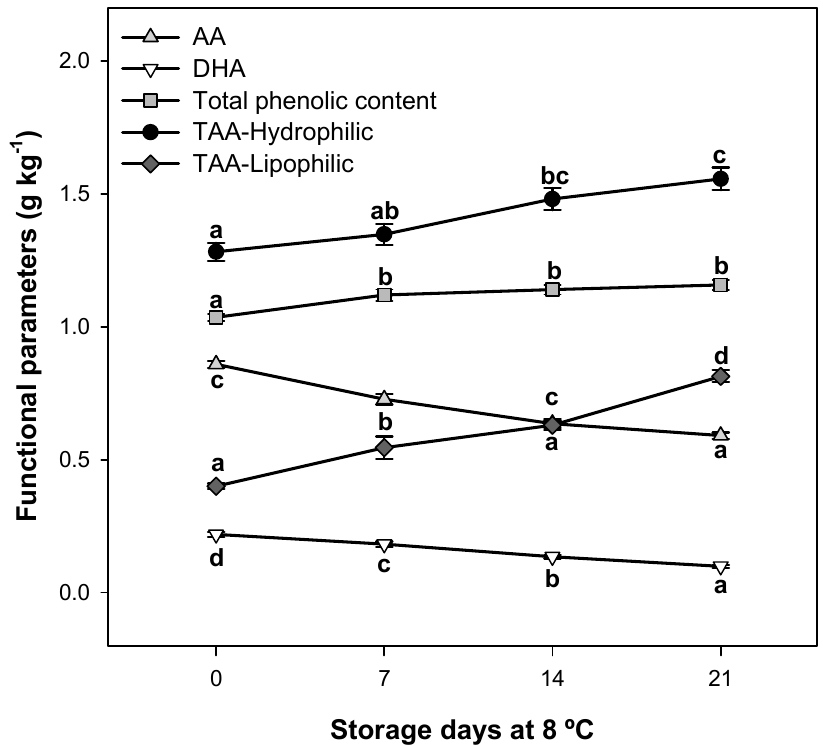
Figure 3. Evolution of functional parameters (g kg − 1 ); ascorbic acid (AA), dehydroascorbic acid (DHA), total phenolic content, and TAA-Hydrophilic and TAA-Lipophilic levels during 21 days of postharvest storage at 8 °C. Lowercase letters show significant differences ( p < 0.05) among storage days at 8 °C.